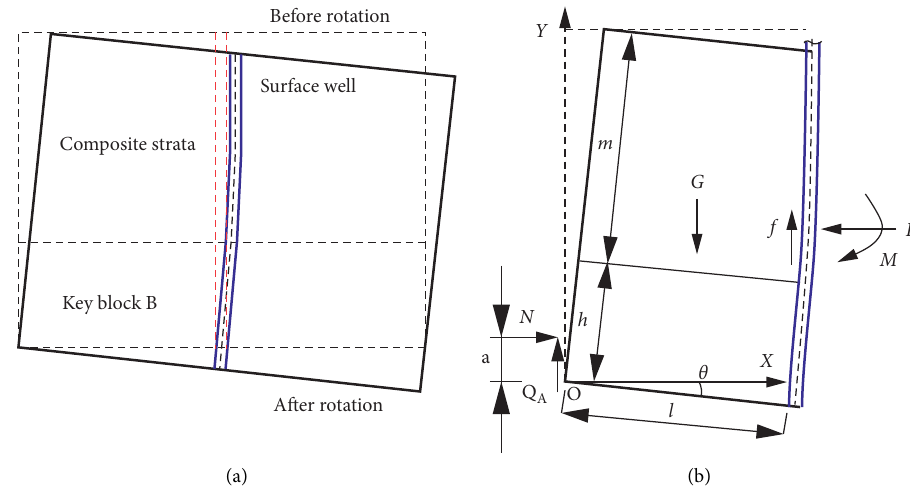
Figure 13: Influence of the rotational deformation of the key block on the surface well deformation. (a) Surface well deformation due to the rotation of key block B. (b) Mechanical model of surface well deformation due to the rotation of key block